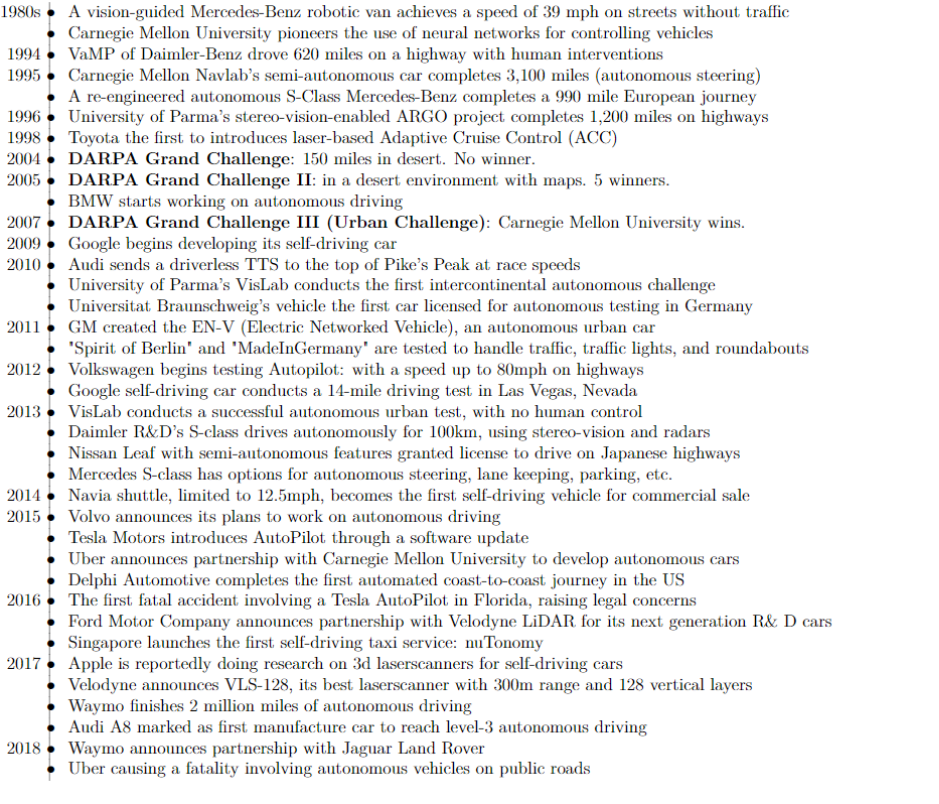
Figure 2. A brief summary of influential events in the history of autonomous driving.